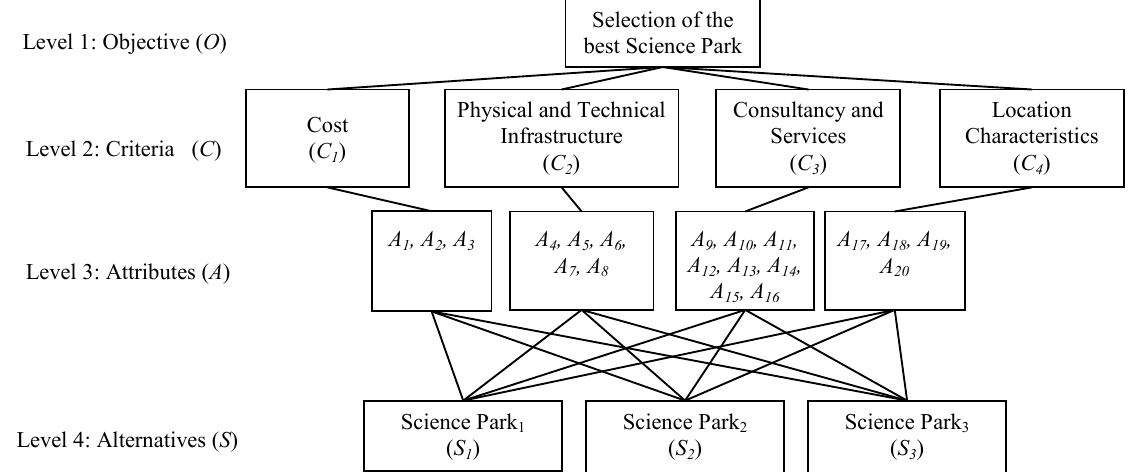
Fig. 1. The hierarchical structure for science park